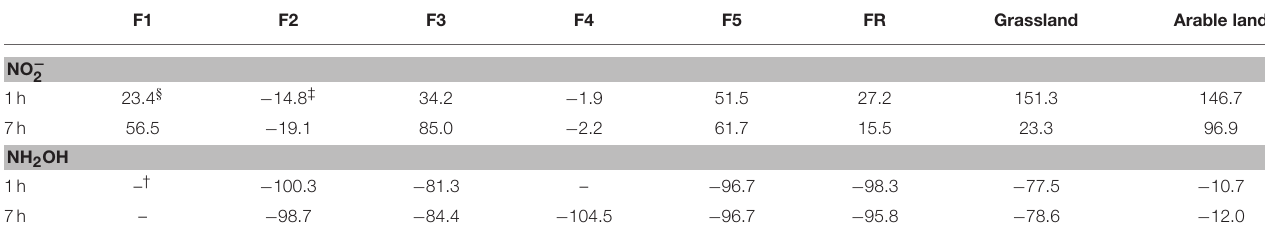
TABLE 2 | Effect (%, n = 3) of anoxic pre-treatment on soil N 2 O emissions after 1 and 7h of incubation of soils with NO − 2 and NH 2 OH additions. F1 F2 F3 F4 F5 FR Grassland Arable land